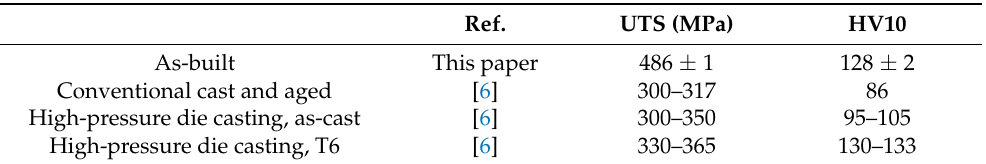
Table 4. Mechanical properties evaluated through the tensile test of L-PBF AlSi10Mg in the as-built state in comparison with casted AlSi10Mg.